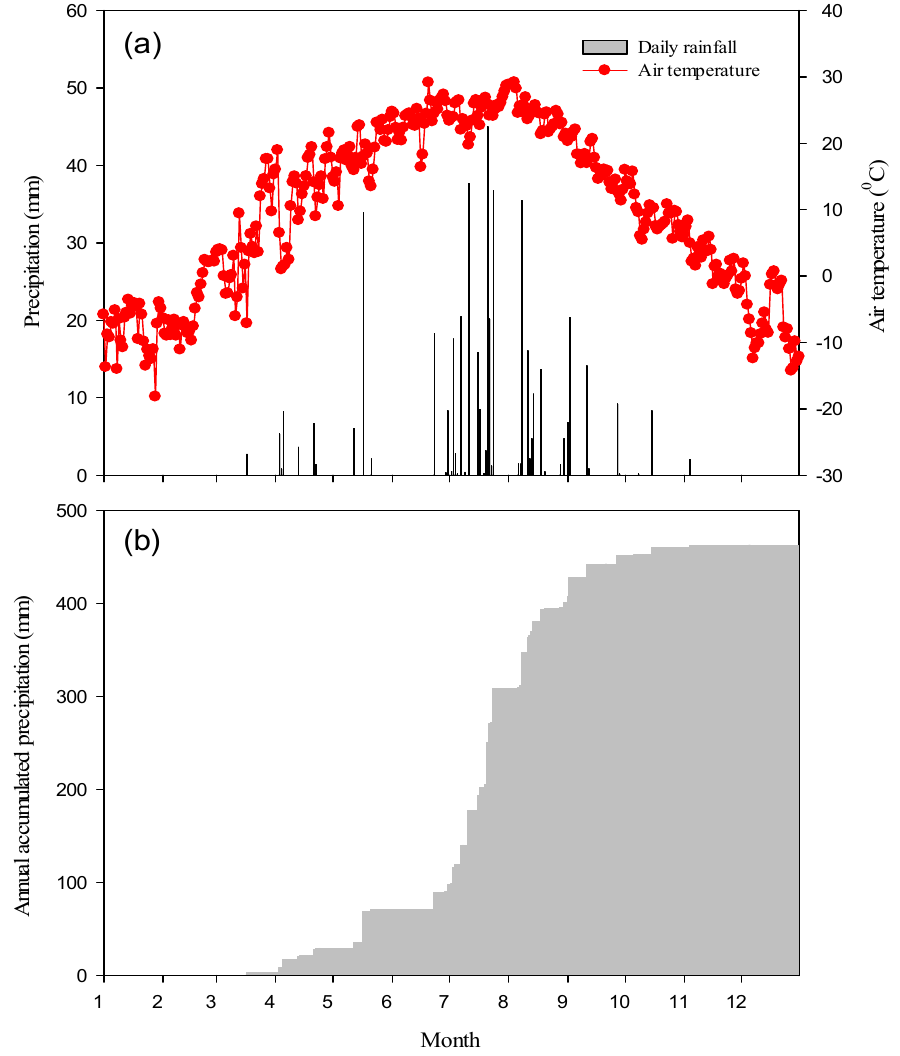
Figure 3. Trends of air temperature and precipitation. ( a ) Daily precipitation and air temperature. ( b ) Accumulated precipitation.